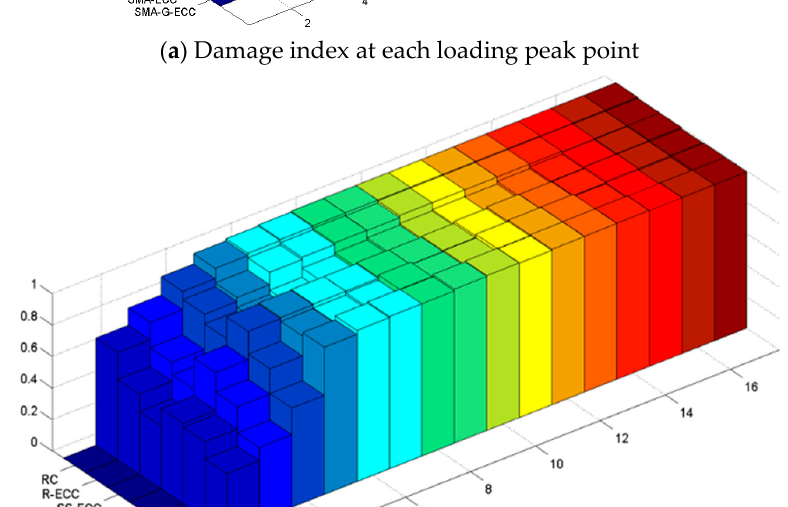
( b ) Fitting curves of self-repairing index Figure 15. Self-repairing index. 5. Conclusions The smart aggregate-based active sensing approach is employed to monitor the crack development of six concrete beams under cyclic loading. The results of failure modes, hysteresis cures and residual deformation were analyzed in detail. The time domain anal- ysis and wavelet packet analysis in terms of energy indices and damage index were con- ducted, and the self-centering effect of tested beams were evaluated. The following con- clusions can be drawn: (1) Noticeable multiple crack behavior and better ductility was observed in beams with ECC. The ECC beam strengthened with GFRP exhibited favorable performance in terms of the load-carrying capacity, ductility, residual deformation and self-centering ef- fect. (2) The damage monitoring results were consistent with the observed crack develop- ment, indicating the feasibility of damage detection for ECC beams using smart aggregate- based active sensing approach. The experimental results provided the basis for the appli- cation of PZT smart aggregates in the ECC structures.